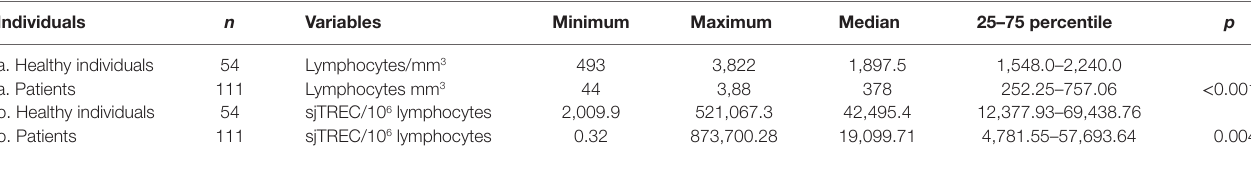
Table 2 | Lymphocyte and signal joint TREC (sjTREC)